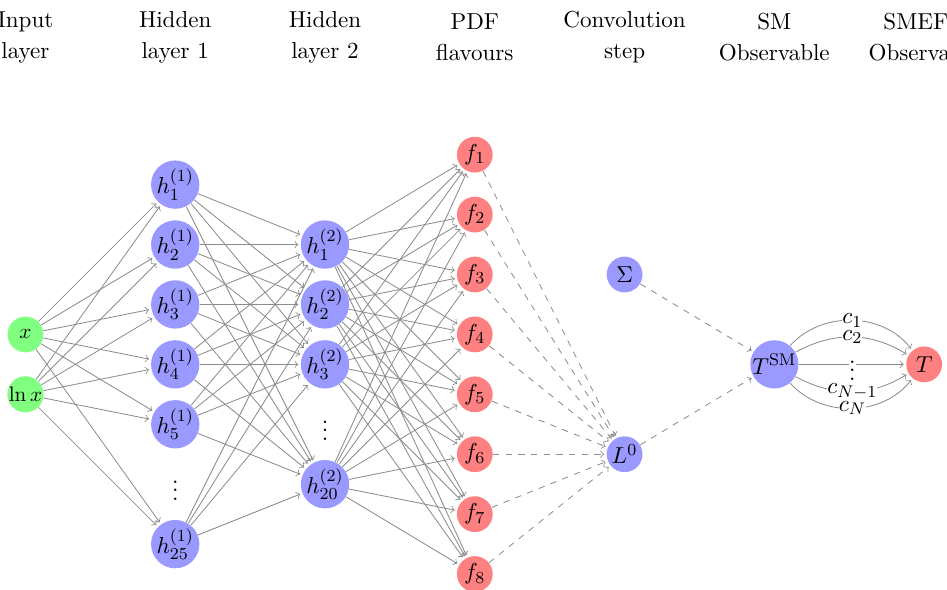
Figure 2 . Schematic representation of the architecture used by SIMUnet in the case of the fit of SMEFT coefficients, in which the dependence of the theoretical prediction T upon the parameters { c n } can be factored into a multiplicative K-factor, as in eq. (2.13). The scheme is the same as the one of figure 1, however the initial scale PDFs L 0 are first convoluted with the relevant SM FK tables to obtain the Standard Model theory prediction ( T SM ). The SM predictions are then incremented by the addition of the linear SMEFT corrections via a final linear combination layer . All solid edges are trainable and thus modified during gradient descent. The full structure of the hidden layers are suppressed for clarity. The precise nature of the manipulation performed by the final layer is outlined in eq.